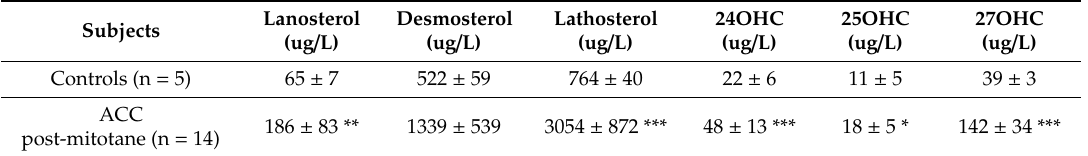
Table 3. Profiling of key cholesterol precursors and of enzymatic oxysterols in plasma of controls and ACC